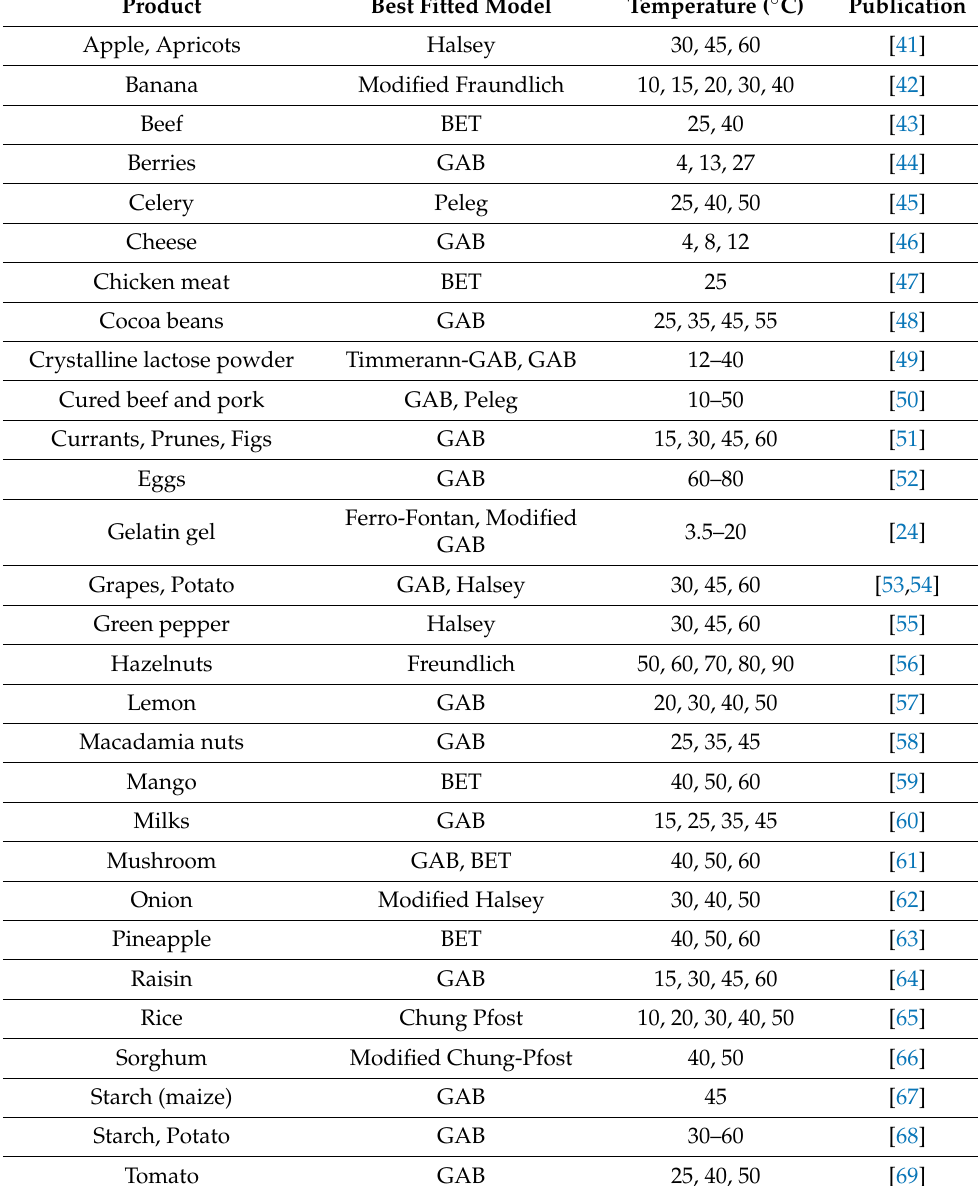
Table 1. Recent findings on sorption isotherms applications (for